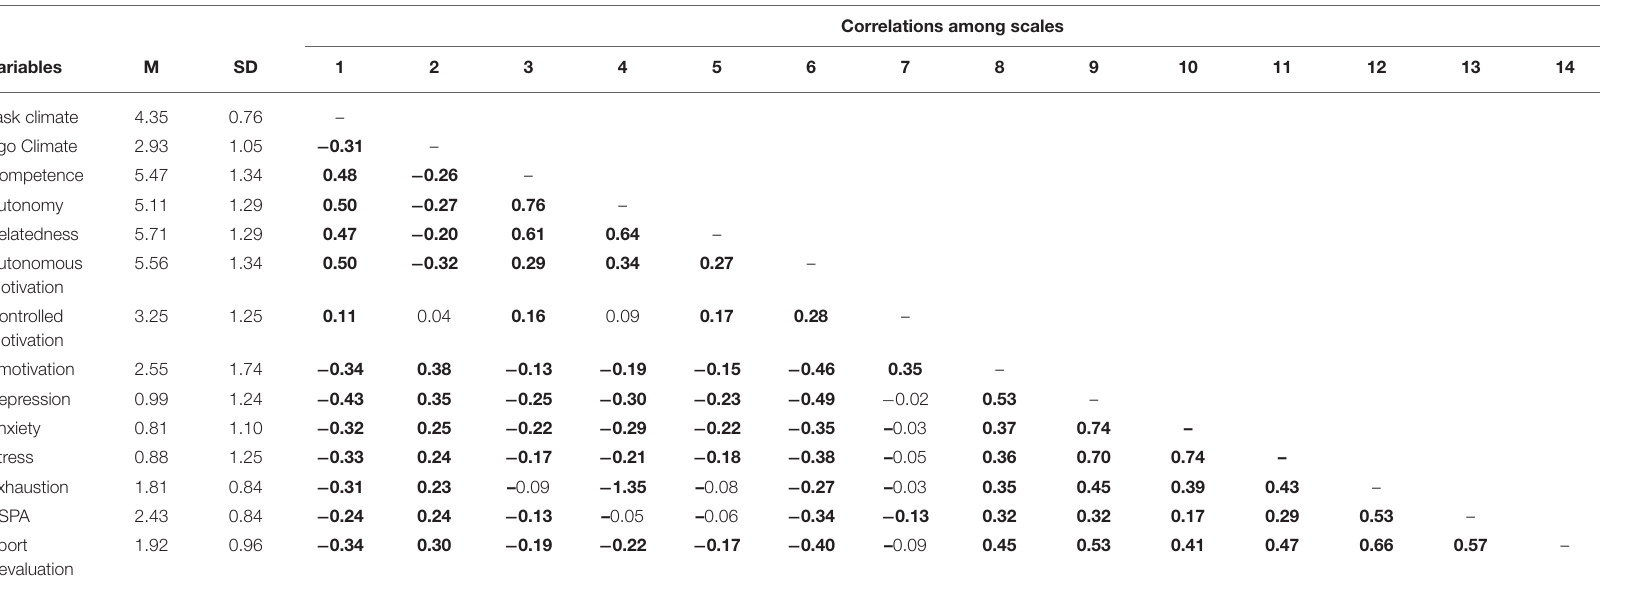
TABLE 2 | Descriptive statistics and bivariate correlations between study